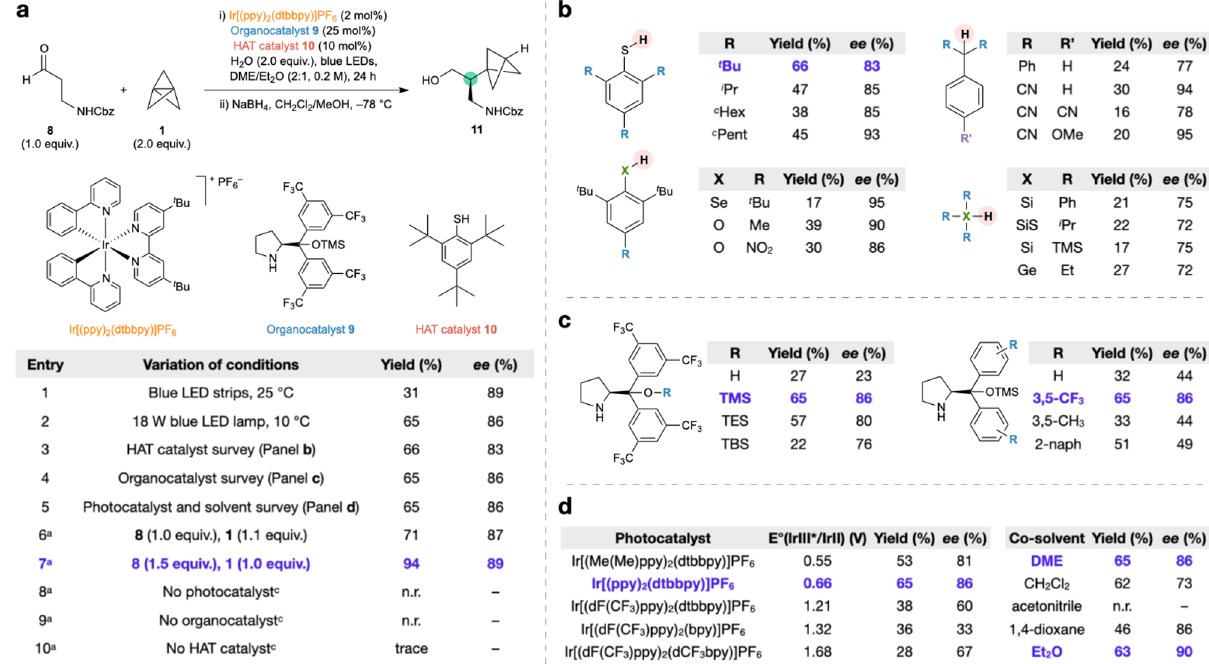
Fig. 3 Optimization of the asymmetric addition to [1.1.1]propellane. a Optimization of reaction conditions. Entries 2-10 were conducted using an 18 W blue LED lamp at 10 °C. All yields are isolated yields. a DME:Et 2 O (1:1, 0.2 M). b A survey of H-atom sources (50 mol% loading) shows HAT catalyst 10 is optimal. c A survey of organocatalysts (25 mol% loading) shows catalyst 9 is optimal. d A survey of photocatalysts shows a range of iridium photocatalysts are effective; see the Supplementary Table 4 for details of reduction potentials. Co-solvents were screened as a 2:1 ratio of co-solvent to Et 2 O (from the solution of 1 ), with an overall concentration of 0.2 M. For full details of reaction optimization, see Supplementary Tables 1 – 7. n.r. no